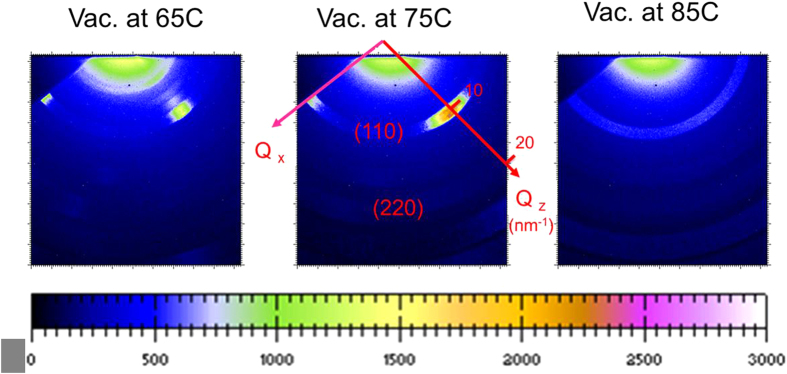
Two dimensional GIWAXS patterns corresponding to the vacuum-deposited CH3NH3PbI3−xClx films prepared at the substrate temperatures of 65, 75 and 85 °C, respectively.